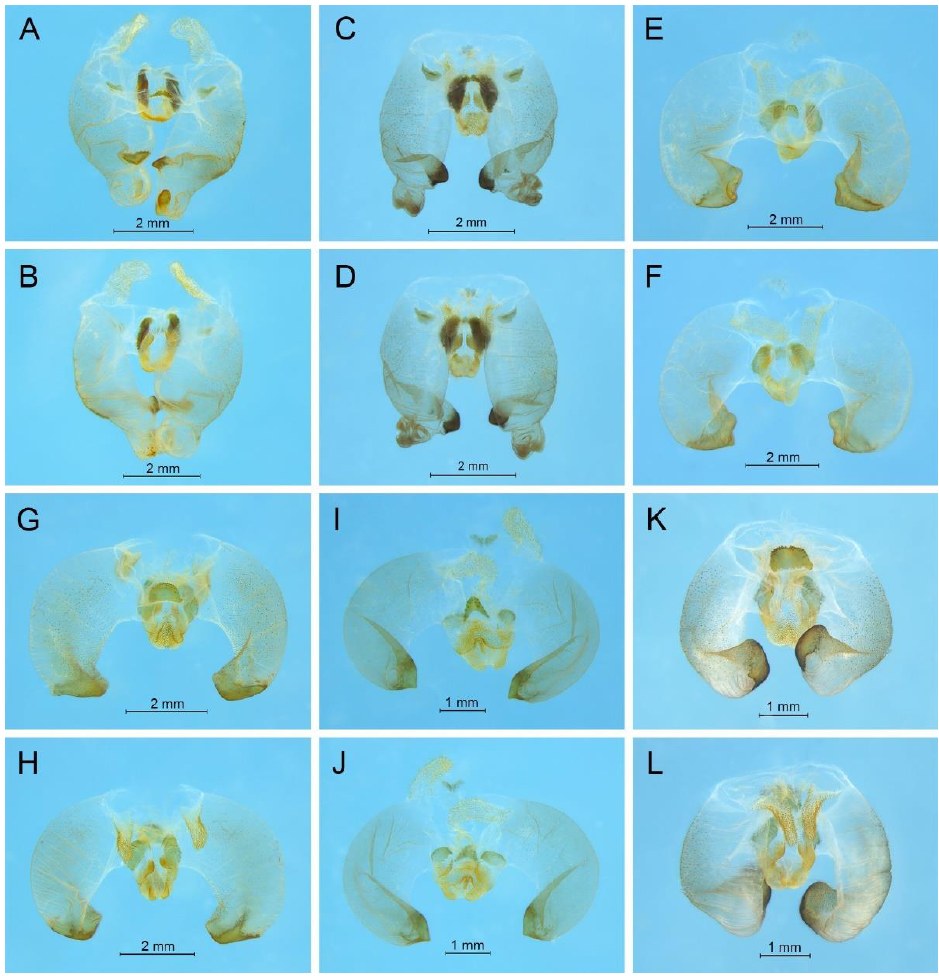
Figure 9. Male genitalia of Pseudotachycines . ( A , C , E , G , I , K ) dorsal view, ( B , D , F , H , J , L ) ventral view: ( A , B ) Pseudotachycines procerus Zhu & Shi sp. nov.; ( C , D ) Pseudotachycines procerus guizhouensis Zhu & Shi ssp. nov.; ( E , F ) Pseudotachycines zhengi Zhu & Shi sp. nov.; ( G , H ) Pseudotachycines nephrus Zhu & Shi sp. nov.; ( I , J ) Pseudotachycines sagittus Zhu & Shi sp. nov.; ( K , I ) Pseudotachycines fengyangshanensis Zhu & Shi sp. nov.